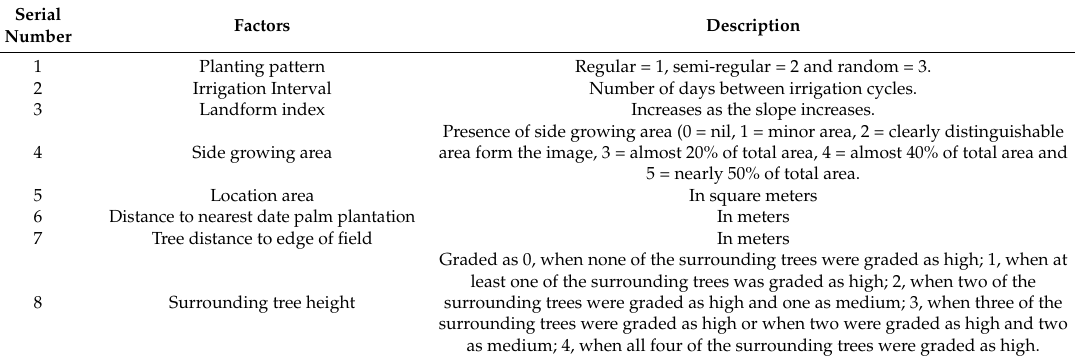
Table 1. Environmental factors included in the study and the scale of each